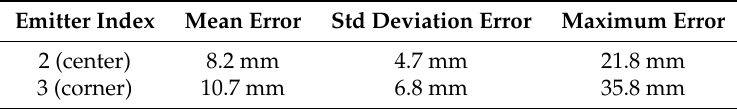
Table 2. Positioning error using one emitter.